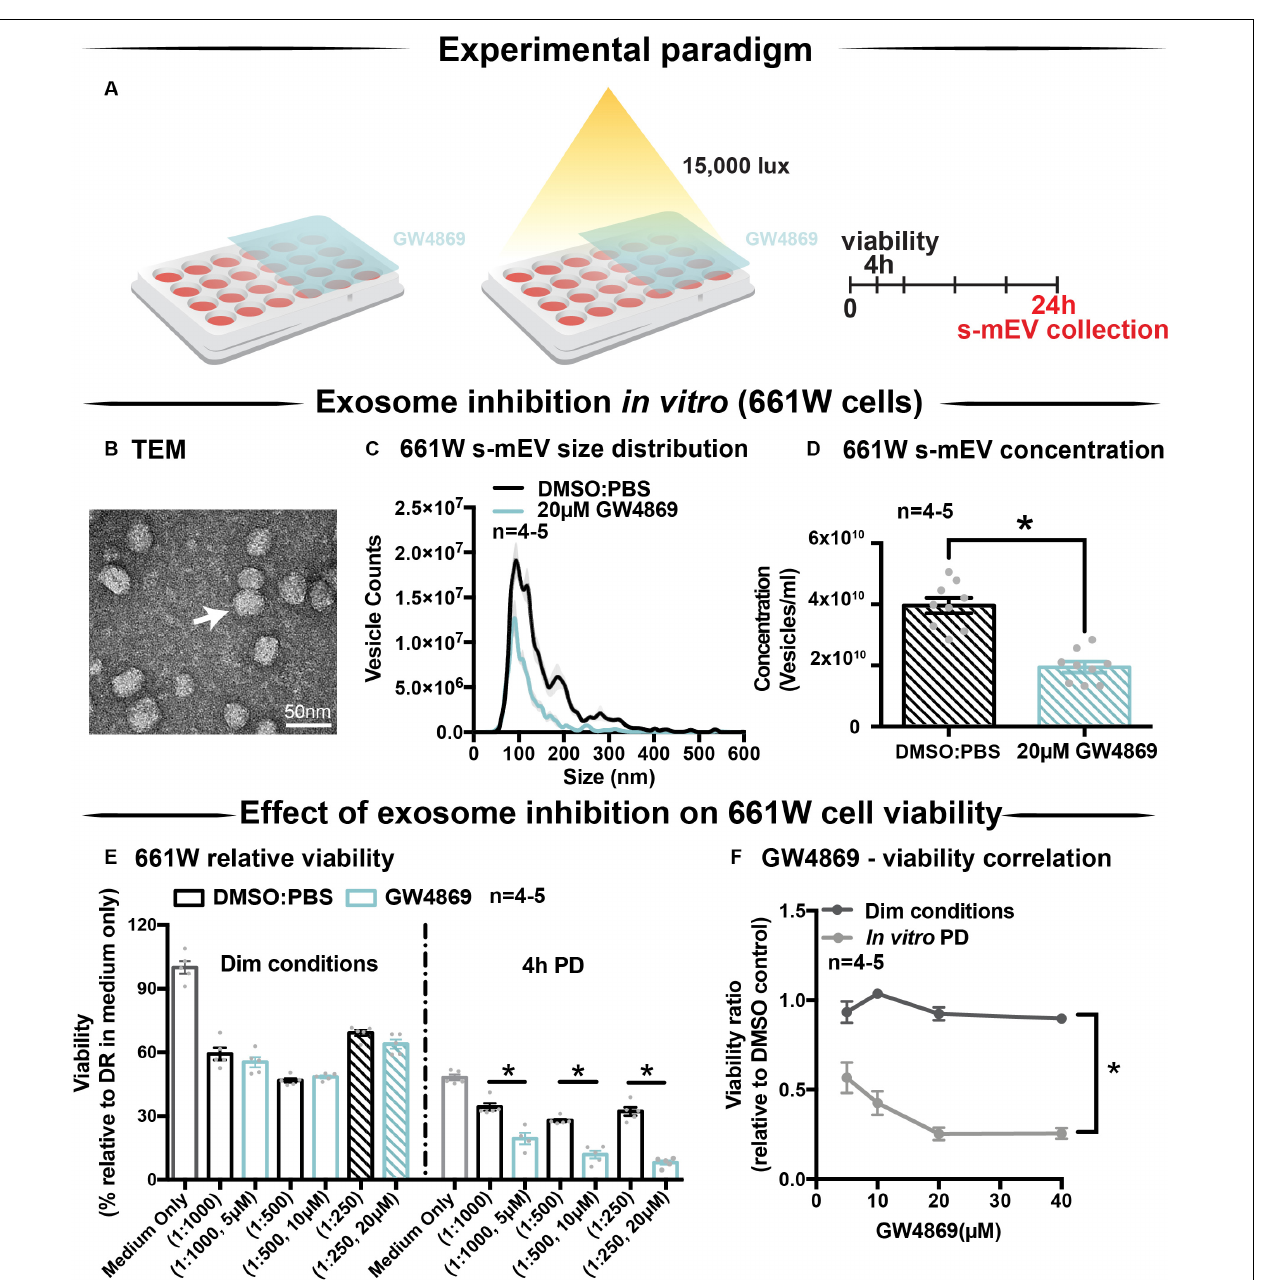
FIGURE 3 | GW4869 inhibits bioavailability of s-mEV in vitro . (A) Experimental paradigm. (B) Representative TEM micrograph showing isolated 661W vesicles. (C,D) s-mEV isolated from 661W photoreceptor-like cells in the presence of exosome inhibitor GW4869 (20 µ M) or DMSO control for 24 h showed a significant reduction in concentration, as measured by NanoSight NS300. ( P < 0.05, n = 4–5). (E) MTT assay to determine viability of 661W cells treated with increasing concentrations of GW4869 or DMSO. Results demonstrated no dose response in viability levels for either treatment under dim conditions, however, significant dose-dependent reduction in cell viability when treated with GW4869 under PD conditions ( P < 0.05). (F) The viability ratio (viability GW4869 / viability DMSO ) of 661W cells treated with increasing concentrations of GW4869 in dim conditions or under 4 h PD showed no change while in dim conditions, however, is reduced between doses of 0–20 µ M GW4869 before reaching a plateau by 40 µ M while in PD conditions. Scale bar = 50 nm. *Patterned bars in (E) represent equivalent dosages/ concentrations and conditions of GW4869/DMSO used in (D) . * denotes = P < 0.05.